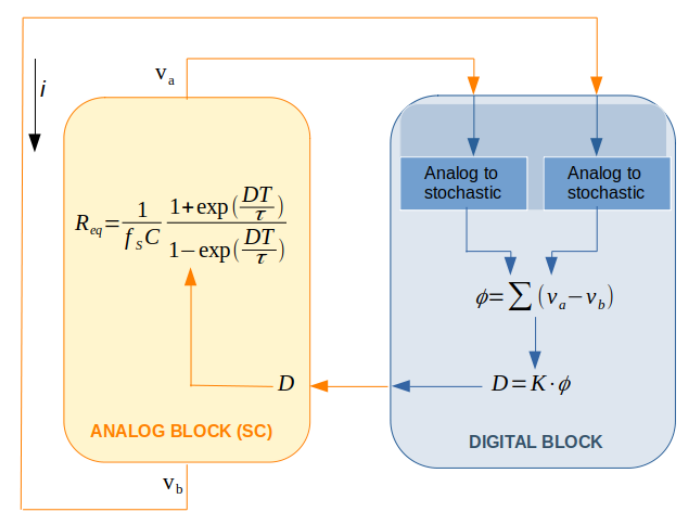
Figure 4. Swiched capacitor memristor emulator (SCME) block diagram.